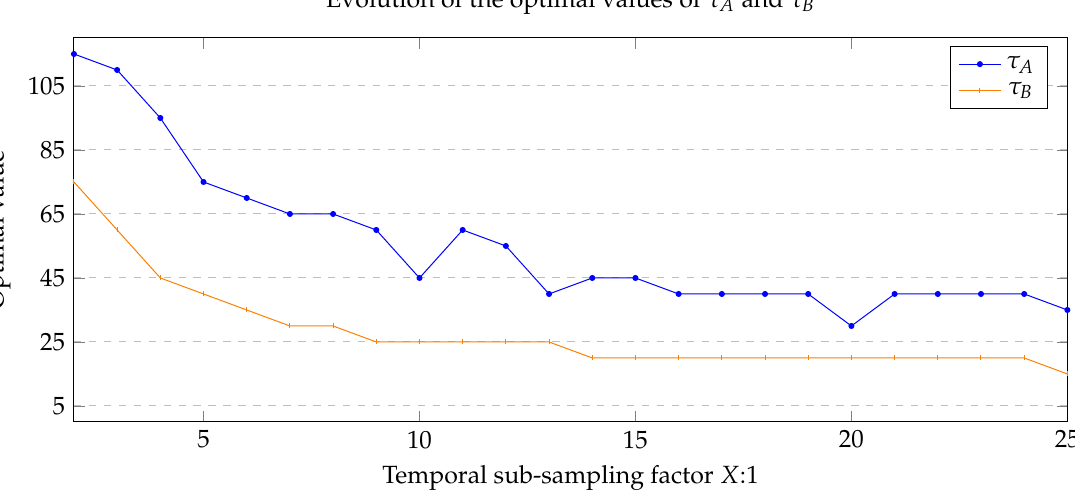
Figure 7. Evolution of the optimal thresholds τ A and τ B of the ASBS method when the semantic frame rate is reduced. Note that the Manhattan distance associated to these thresholds is computed on 8-bit color values. The results are shown here for the PAWCS algorithm, and follow the same trend for the IUTIS-5, SuBSENSE, and WeSamBe BGS